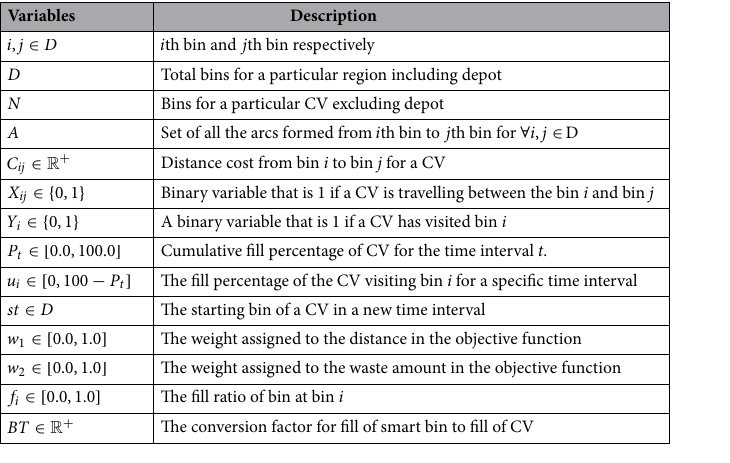
Table 1. Variable